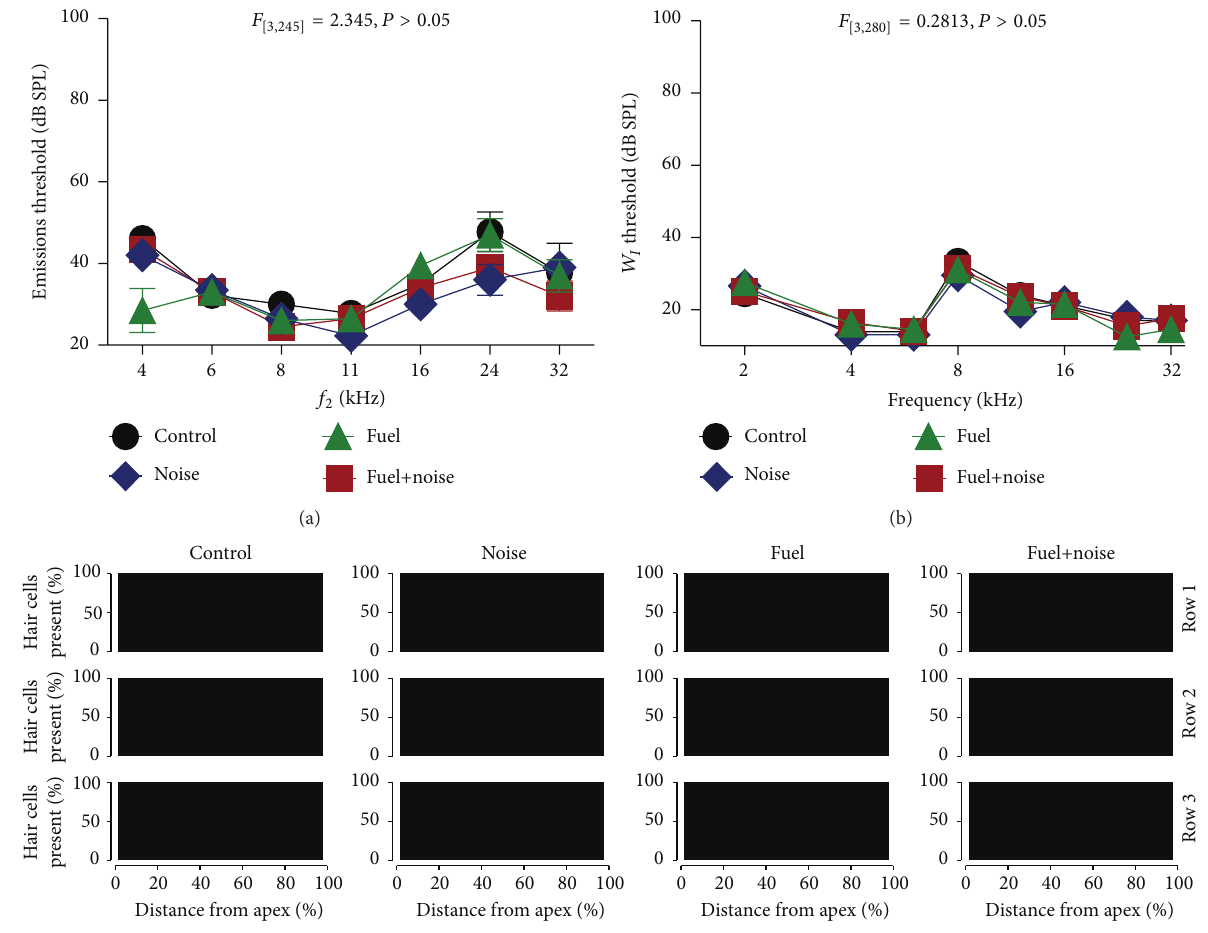
Figure 1: Normal thresholds. (a) Emissions thresholds revealed no major differences in preneural sensitivity between the experimental groups. (b) Synchronous compound action potential ( 𝑊 𝐼 ) also revealed no major differences in neural sensitivity between the experimental groups. (c) Cytocochleograms showed no loss (all black) of sensory cells (outer hair cells) as a function of distance along the neurosensory epithelium. Error bars in this and all figures are ± 1 standard